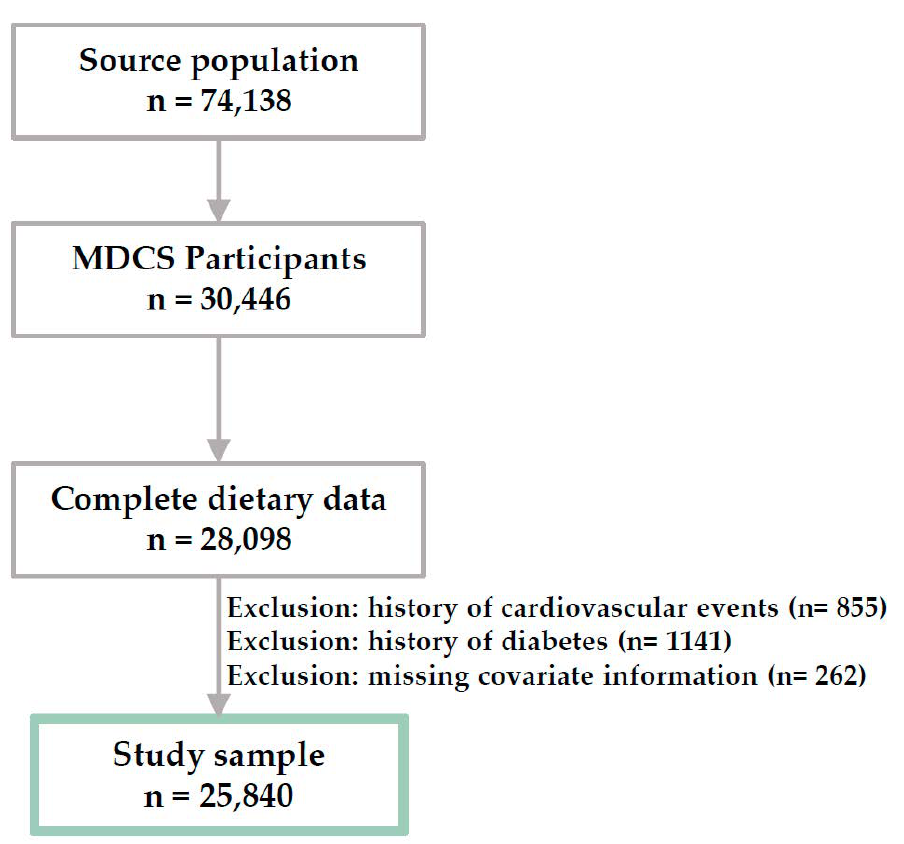
Figure 1. Study sample selection. MDCS: Malmö Diet and Cancer